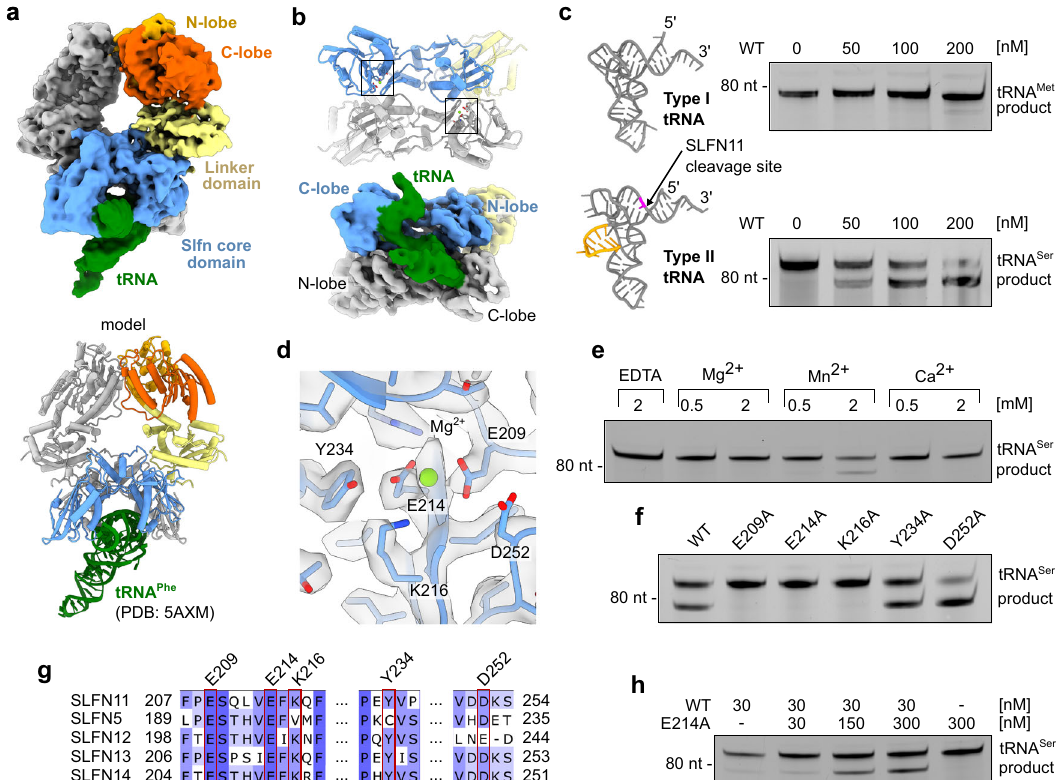
Fig. 2 | SLFN11 tRNA recognition and nuclease activity. a Cryo-EM density map forSLFN11boundtotRNAwithproposedstructuralmodelofdockedyeasttRNA Phe (PDB code 5AXM). b Bottom view of Slfn core domains with highlighted nuclease active sites. Cryo-EM density map for tRNA bound between N- and C-lobes of Slfn core domains. c Structural models of type I (tRNA Met , PDB code 2FMT) and type II (tRNA Ser , model created by RNAComposer 53,54 ). Variable loop of type II tRNA is coloured in orange and SLFN11 cleavage site in pink (nt 75). SLFN11 endonuclease activity towards respective tRNAs demonstrated in nuclease assays. d Close-up